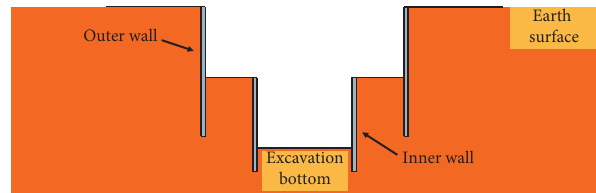
Figure 1: Schematic diagram of earth stepped-twin retaining wall.